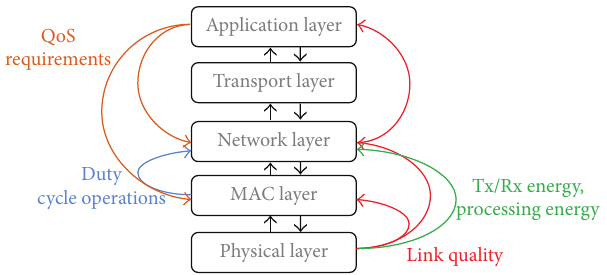
Figure 4: The proposed QoS model framework for WSNs.